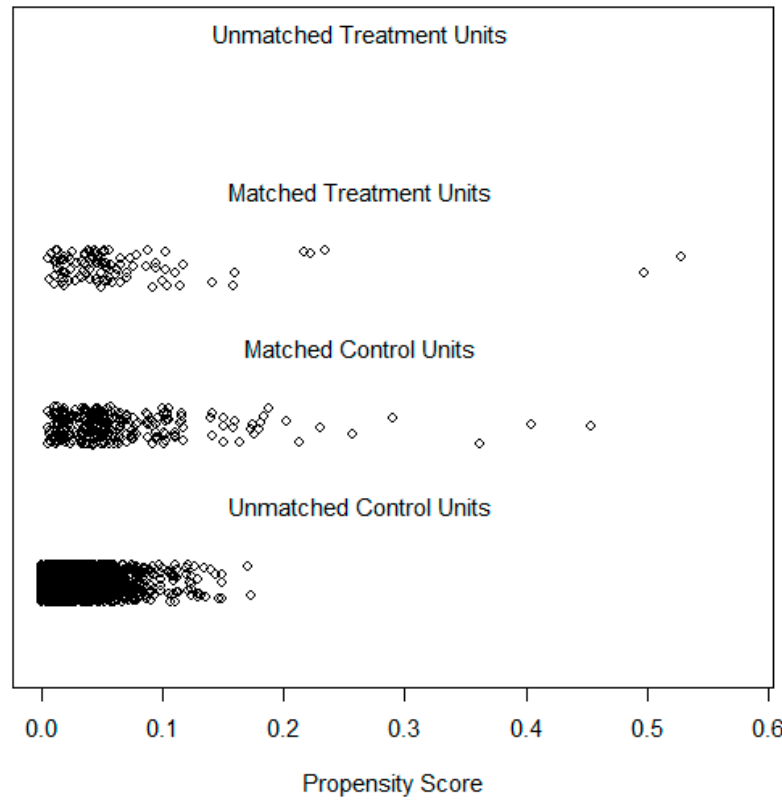
Figure 1. Jitter plot of the propensity score for the matched and unmatched cases. Table 1. Description of the sample and single analysis for the factors associated with MENM among medical professionals before and after propensity score matching.